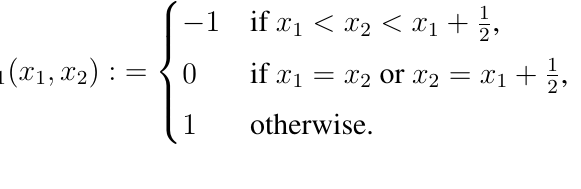
Figure 1. Example 2: The payoff functions of G .